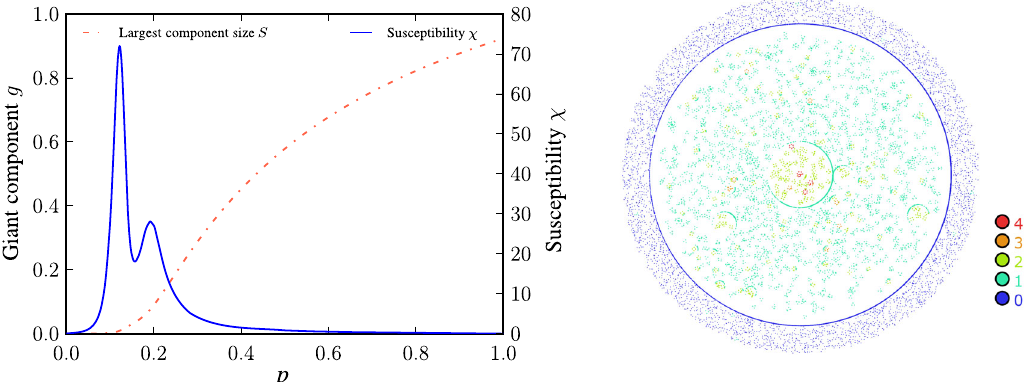
FIG. 13. Left panel: Bond percolation simulations for the Pokec online social network. The relative size of the largest connected component g and its susceptibility χ as a function of the bond occupation probability p are shown. Right panel: m -core